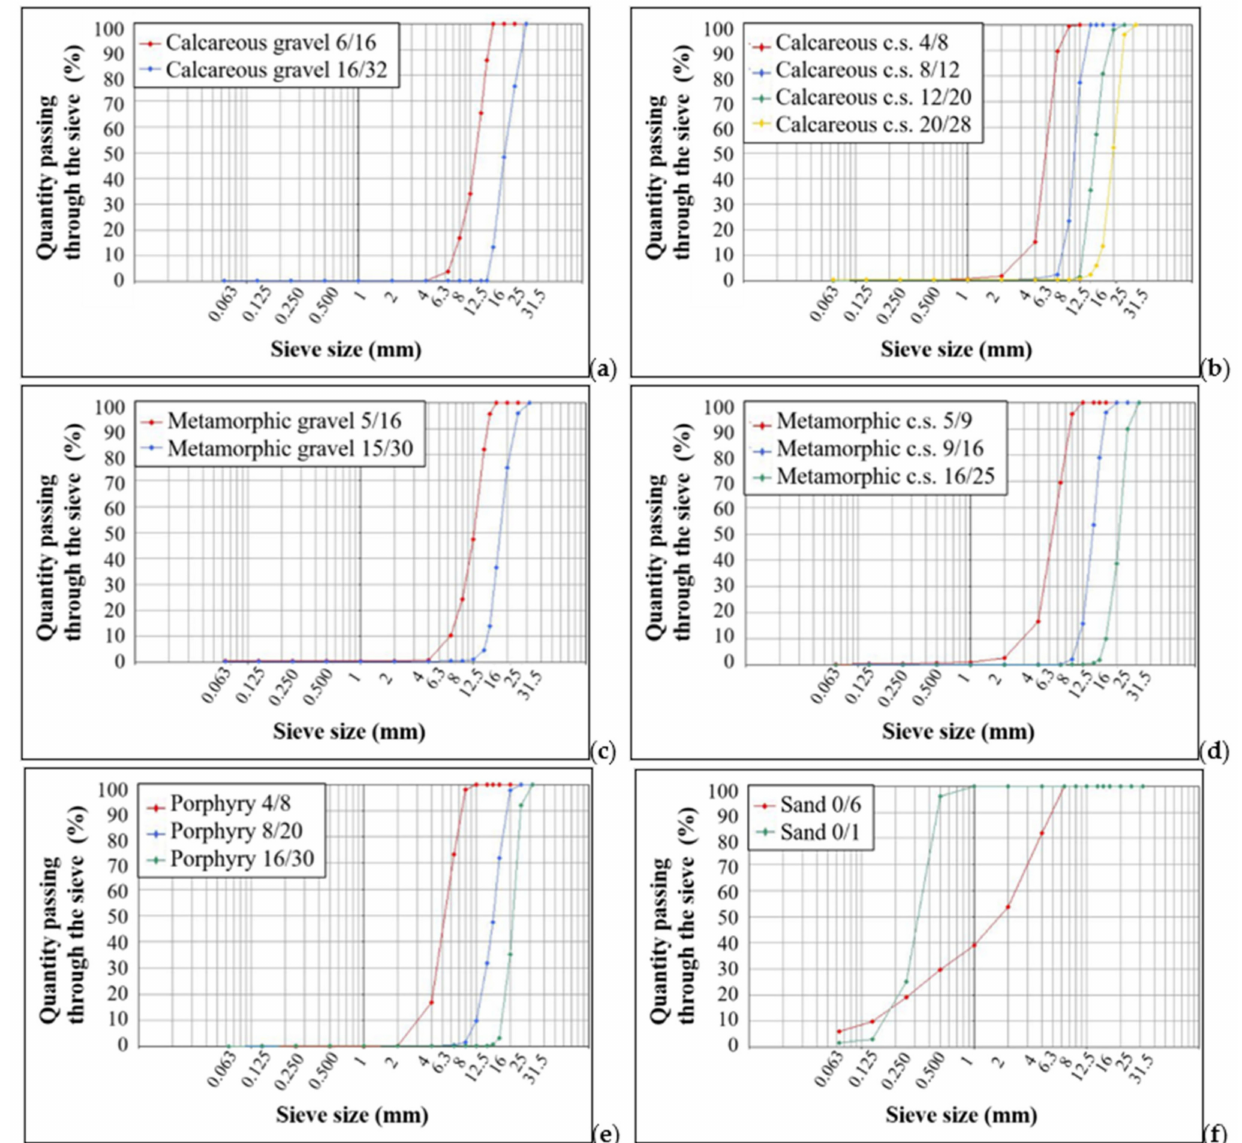
Figure 3. Grain size distributions of the samples analyzed, following the Bolomey’s curve: ( a ) calcareous gravel sam- ples; ( b ) calcareous crushed stone samples (c.s. in the graph means crushed stone); ( c ) metamorphic gravel samples; ( d ) metamorphic crushed stone samples (c.s. in the graph means crushed stone); ( e ) porphyry samples; ( f ) sand